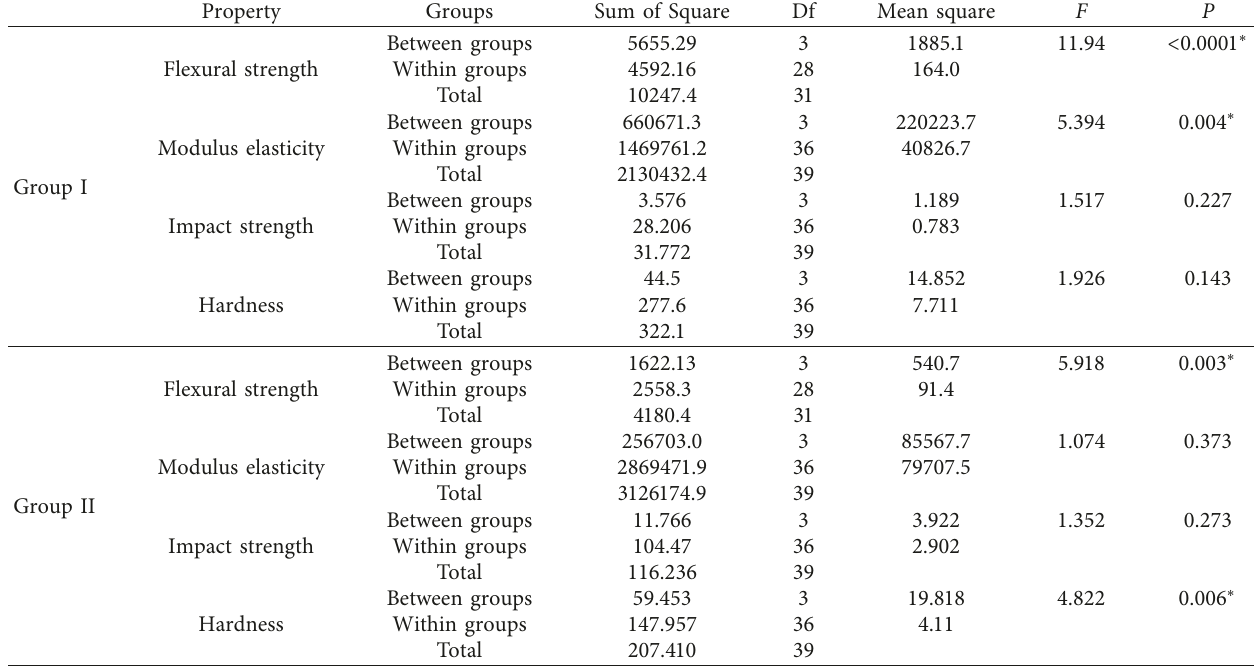
Table 2: Effect of different concentration levels on tested properties of conventionally and autoclave polymerized denture base